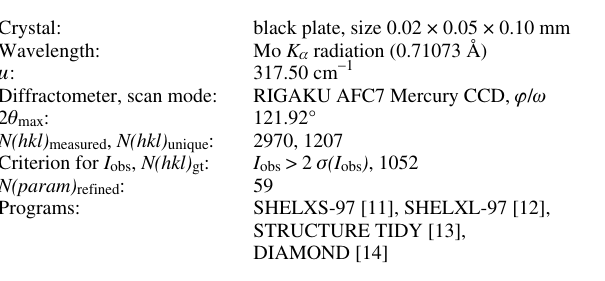
Table 1. Data collection and